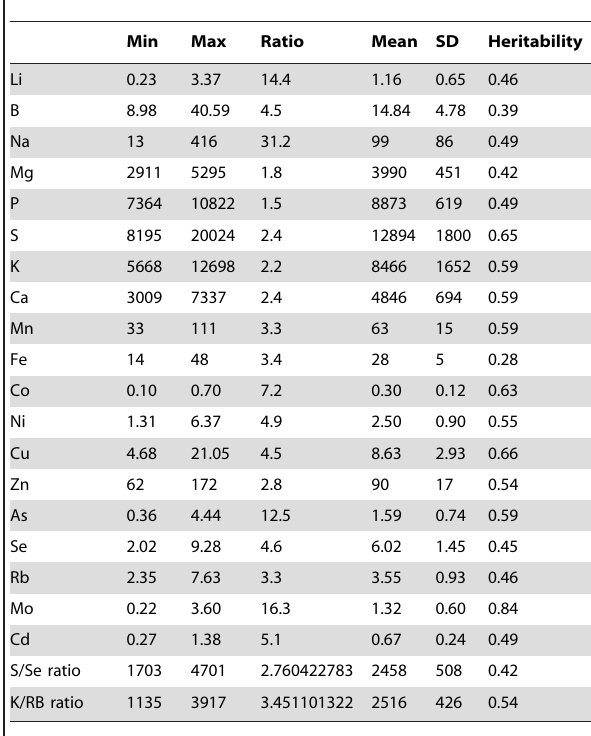
Table 3. Summary of Soil Seed Experiment.